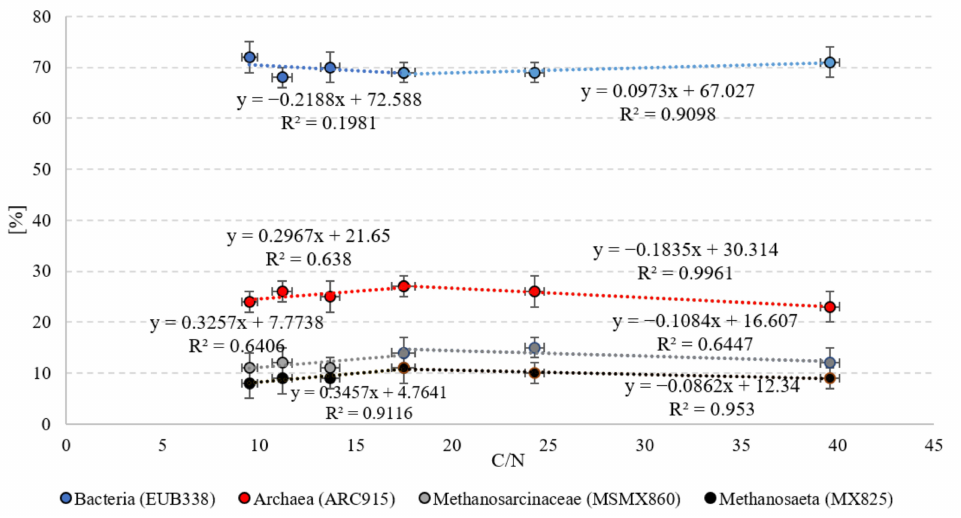
Figure 4. Correlations between the proportion of microbes and the C/N